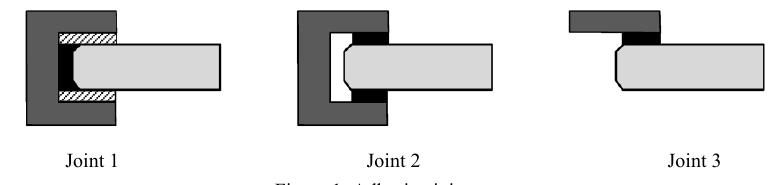
Figure 1: Adhesive joint